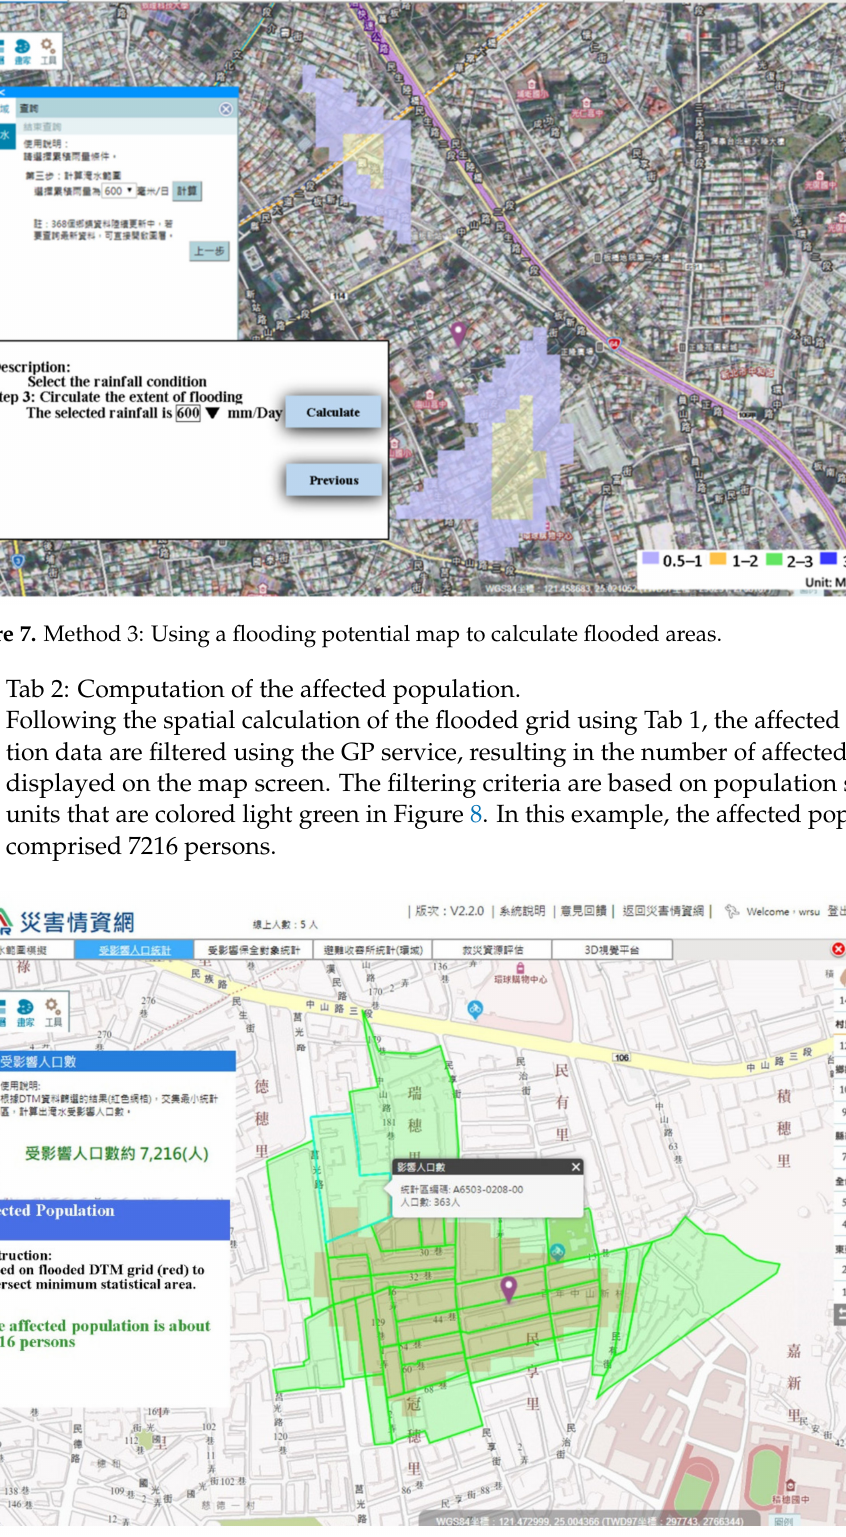
Figure 8. Tab 2: Estimating the flood-affected